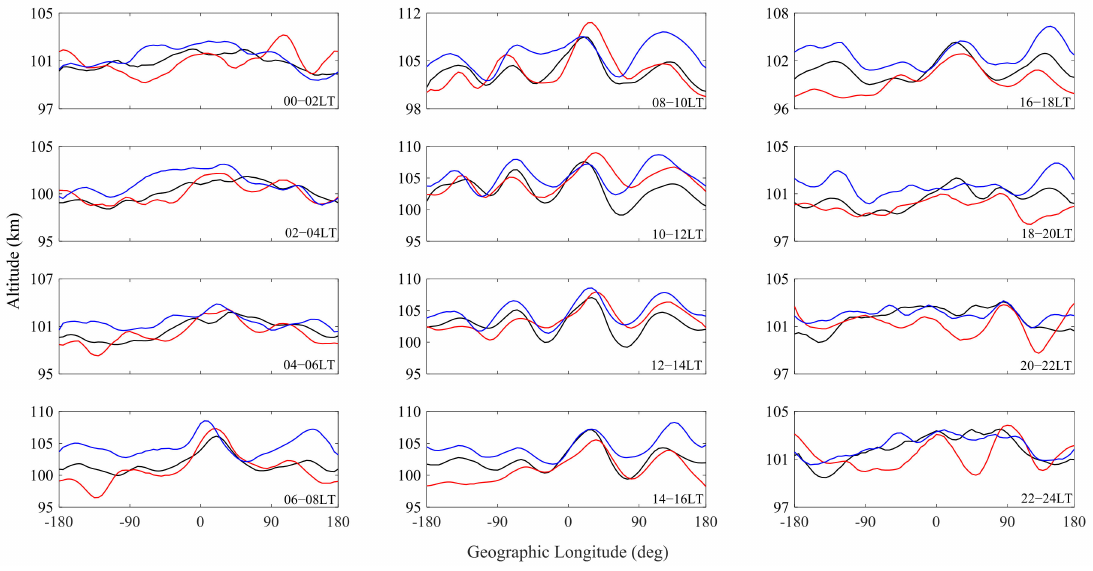
Figure 4. Same as Figure 3, but for 0–30 ◦